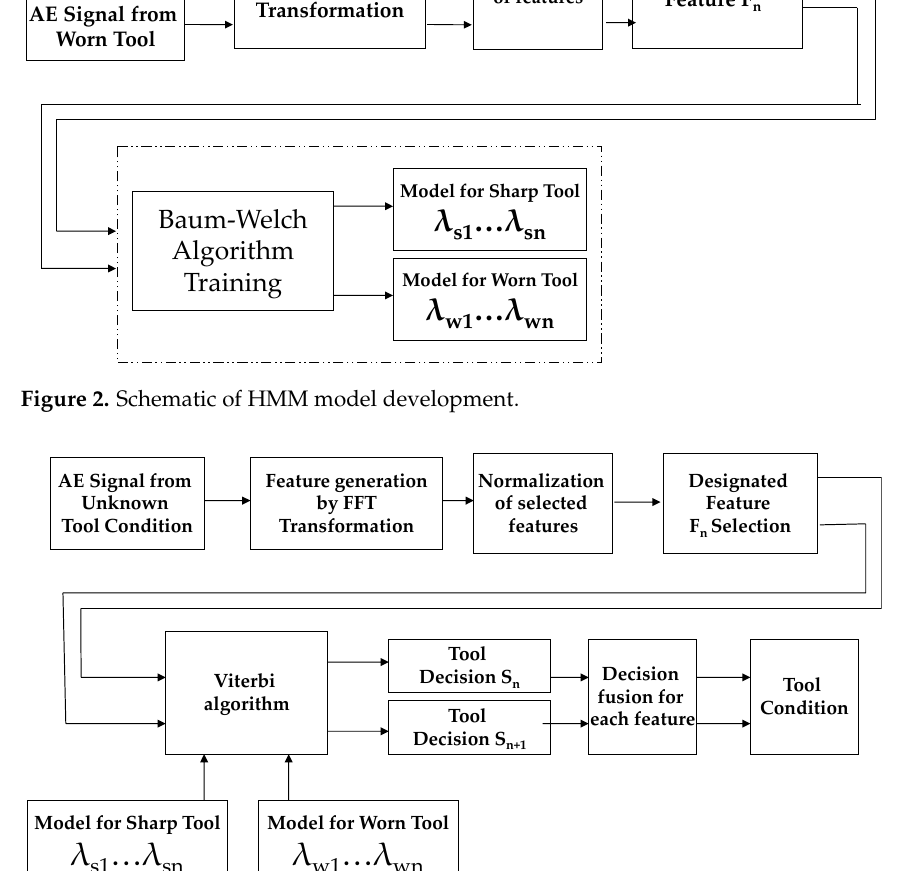
Figure 3. Schematic of tool condition verification.